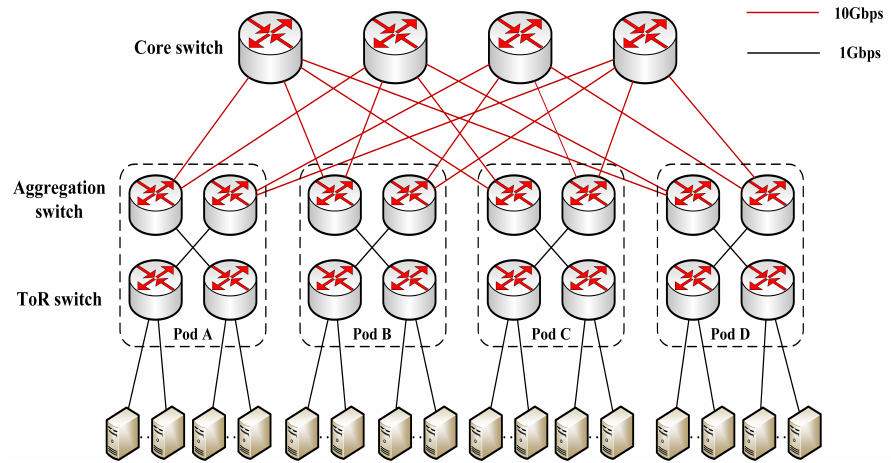
Figure 9. The topology for large-scale experiments.